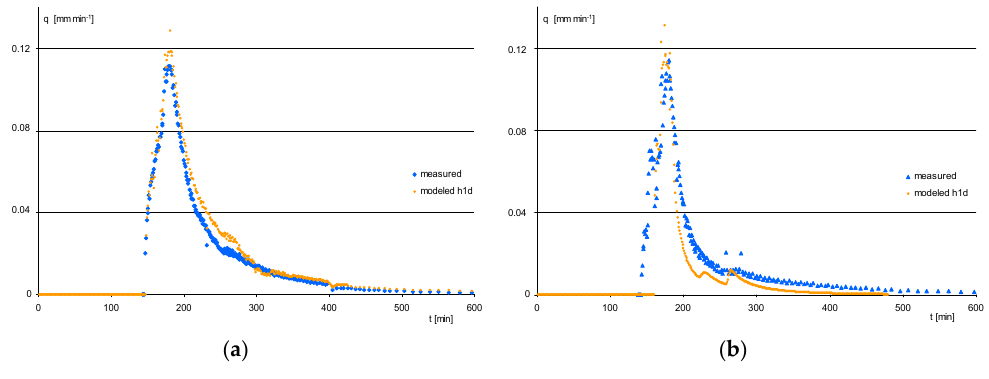
Figure 3. Comparison of green roofs with zeolite ( a ) and pumice ( b )—hydrographs for measured values and simulated with the model Hydrus 1D on 28 June 2017. For the event of the 28th of July used to calibrate the model, the maximum error (ME) was 0.18 mm·min − 1 (GR1) and 0.07 (GR2), while the calculated statistics describing the relative value of residual variance, the Nash-Sutcliffe efficiency (NSE), assumed values at the level from 0.93 (GR1) to 0.58 (GR2). A simulation can be accepted as satisfactory when NSE > 0.5 (higher model accuracy for NSE values close to 1) [36]. The calculated NSE and ME values for validation are presented in the Table 4. During the validation, the models designed as zeolite and pumice-based displayed good representation of flow volume and intensity, accurately simulating events observed in other periods. It can, therefore, be concluded that in both cases the level of matching achieved was close to good [37]. Table 4. Nash–Sutcliffe efficiency (NSE) index and maximum error (ME) of the total runoff volume for the observed rainfall events used for the validation. Event Date (dd/mm)